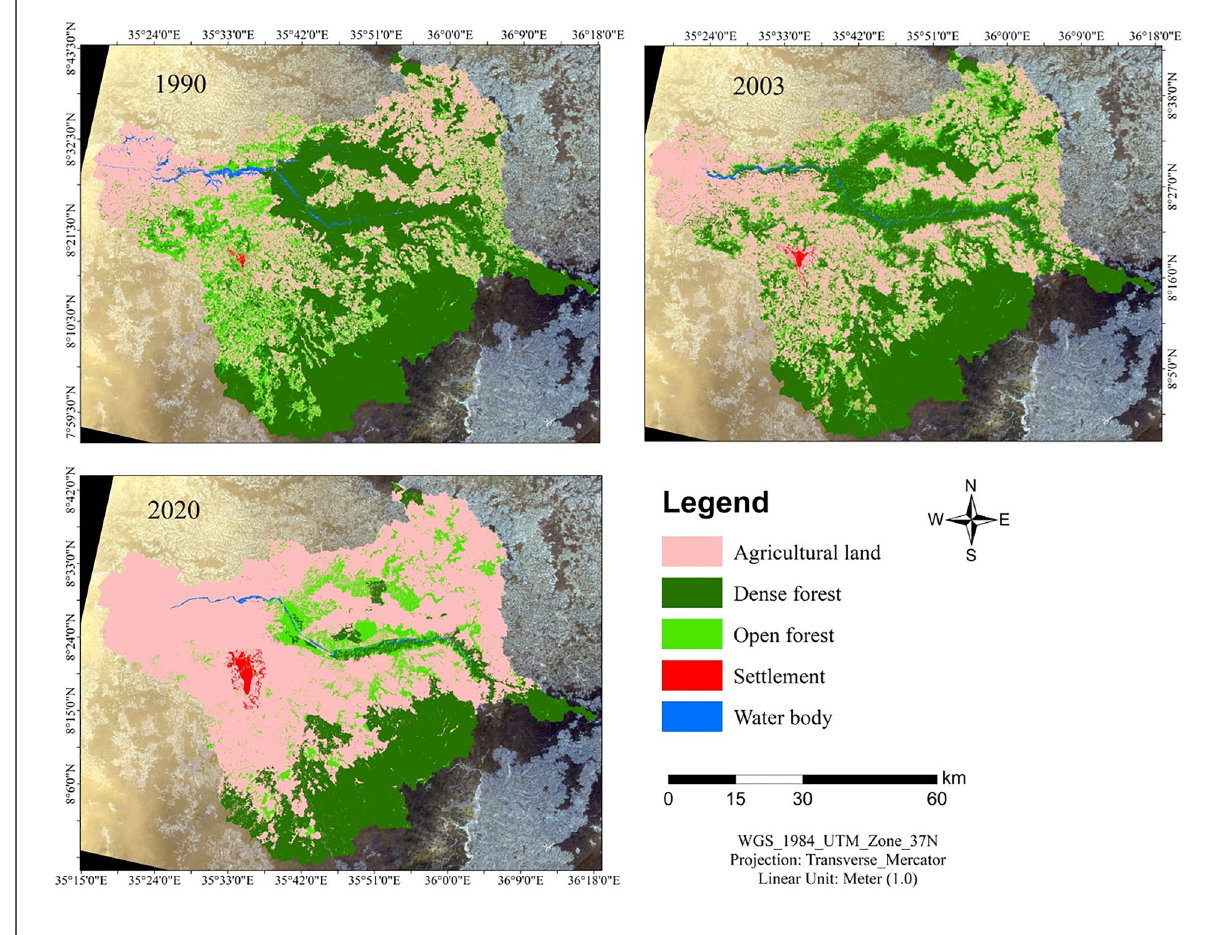
Fig. 3 LULC map of 1990, 2003, and 2020 Table 3 LULC areas in 1990, 2003 and 2020